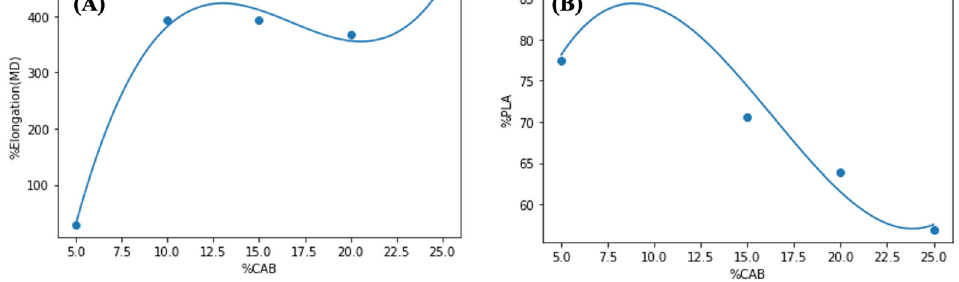
Figure 12. The global models of (%CAB, %Elongation ( A )) and (%CAB, %PLA ( B